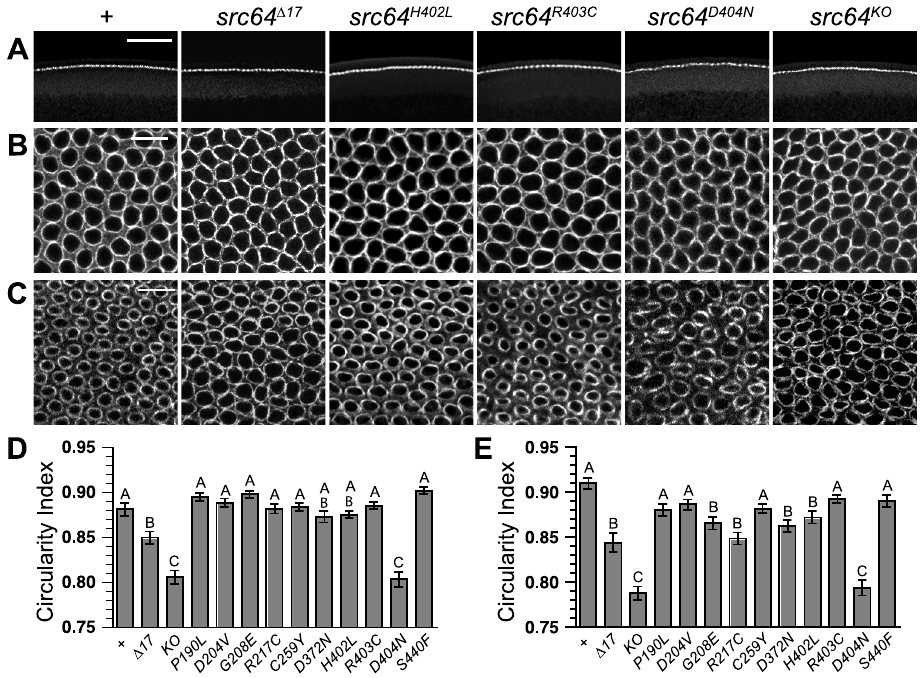
Figure 3. Cellularization microfilament defects in src64 mutant embryos. Embryos are stained with antibody to myosin II heavy chain. (A) Cross-sections showing the early cellularization front. Furrow canal depths are less uniform, producing a wavy and irregular cellularization front in src64 D 17 , src64 H402L , src64 D404N and src64 KO mutant embryos. Scale bar, 50 m m. (B) Grazing section projections of early cellularization stage embryos showing the microfilament network. Microfilament rings of src64 D 17 , src64 H402L , src64 D404N and src64 KO mutant embryos are irregular. Scale bar, 10 m m. (C) Grazing section projections of late cellularization stage embryos showing microfilament rings. Microfilament rings of src64 D 17 , src64 H402L , src64 D404N and src64 KO mutant embryos are irregular and less constricted than the microfilament rings of wild-type embryos and src64 R403C mutant embryos. Scale bar, 10 m m. (D) Microfilament ring circularity during early cellularization. A, does not differ from + ; AB, differs from + and src64 D 17 ; B, does not differ from src64 D 17 allele but differs from + (P , 0.01); C, does not differ from src64 KO but differs from + (P , 0.001) and src64 D 17 (P , 0.001). Error bars are SEM. (E) Microfilament ring circularity during late cellularization. A, does not differ from + ; B, does not differ from src64 D 17 but differs from + (P , 0.05); C, does not differ from src64 KO but differs from + (P , 0.001) and src64 D 17 (P , 0.001). Error bars are SEM.